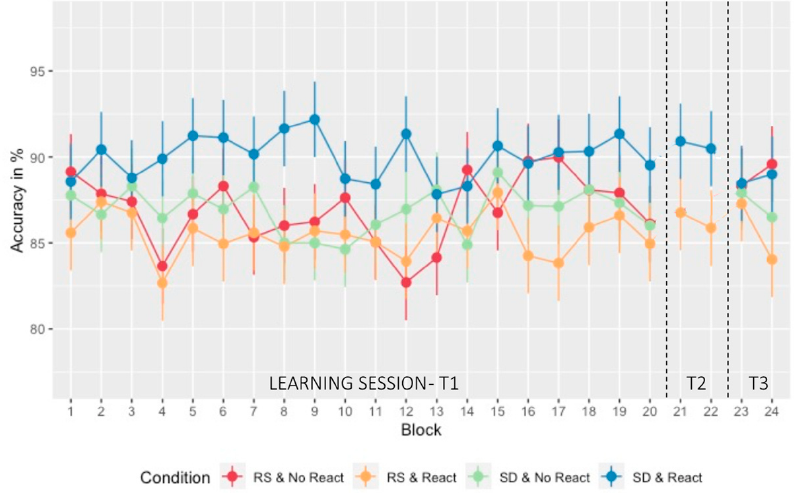
Figure 2. Performance evolution (speed): Mean RT (in msec) at the SRTT plotted over the different testing days and blocks with standard deviation. The learning session consisted of 20 sequential blocks (blocks 1 to 20 with block 18 pseudo-random—T1). On the next morning and following the experimental night (regular sleep (RS)/sleep deprivation (SD)), a short reactivation took place on two blocks (blocks 21 and 22—T2) for the Morning Reactivation groups (React) only. After three nights of recovery sleep at home, performance was assessed for all groups on two last blocks (blocks 23 and 24—T3). *** p < 0.001. RS & No React (red) = regular sleep and no Morning Reactivation; RS & React -(orange) = regular sleep with Morning Reactivation; SD & No React (green) = sleep depri- vation and no Morning Reactivation; SD & React (blue) = sleep deprivation with Morning Reactiva- tion.